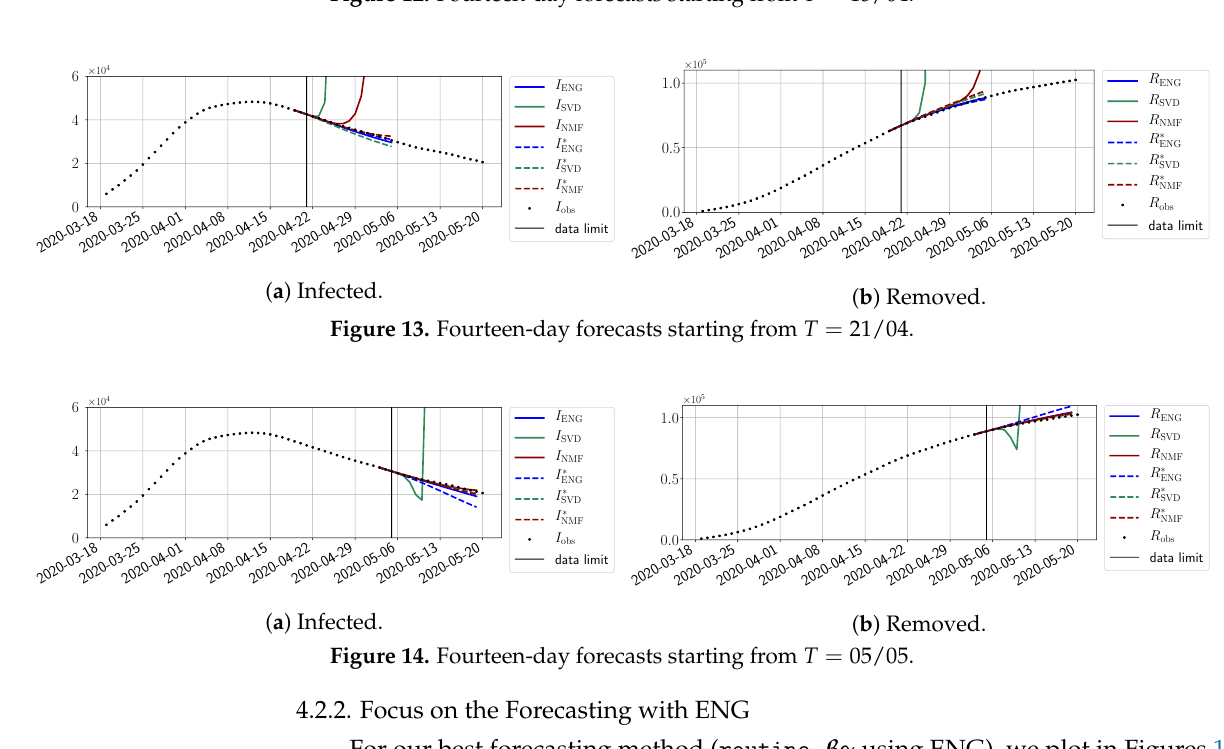
Figure 12. Fourteen-day forecasts starting from T = 15/04.